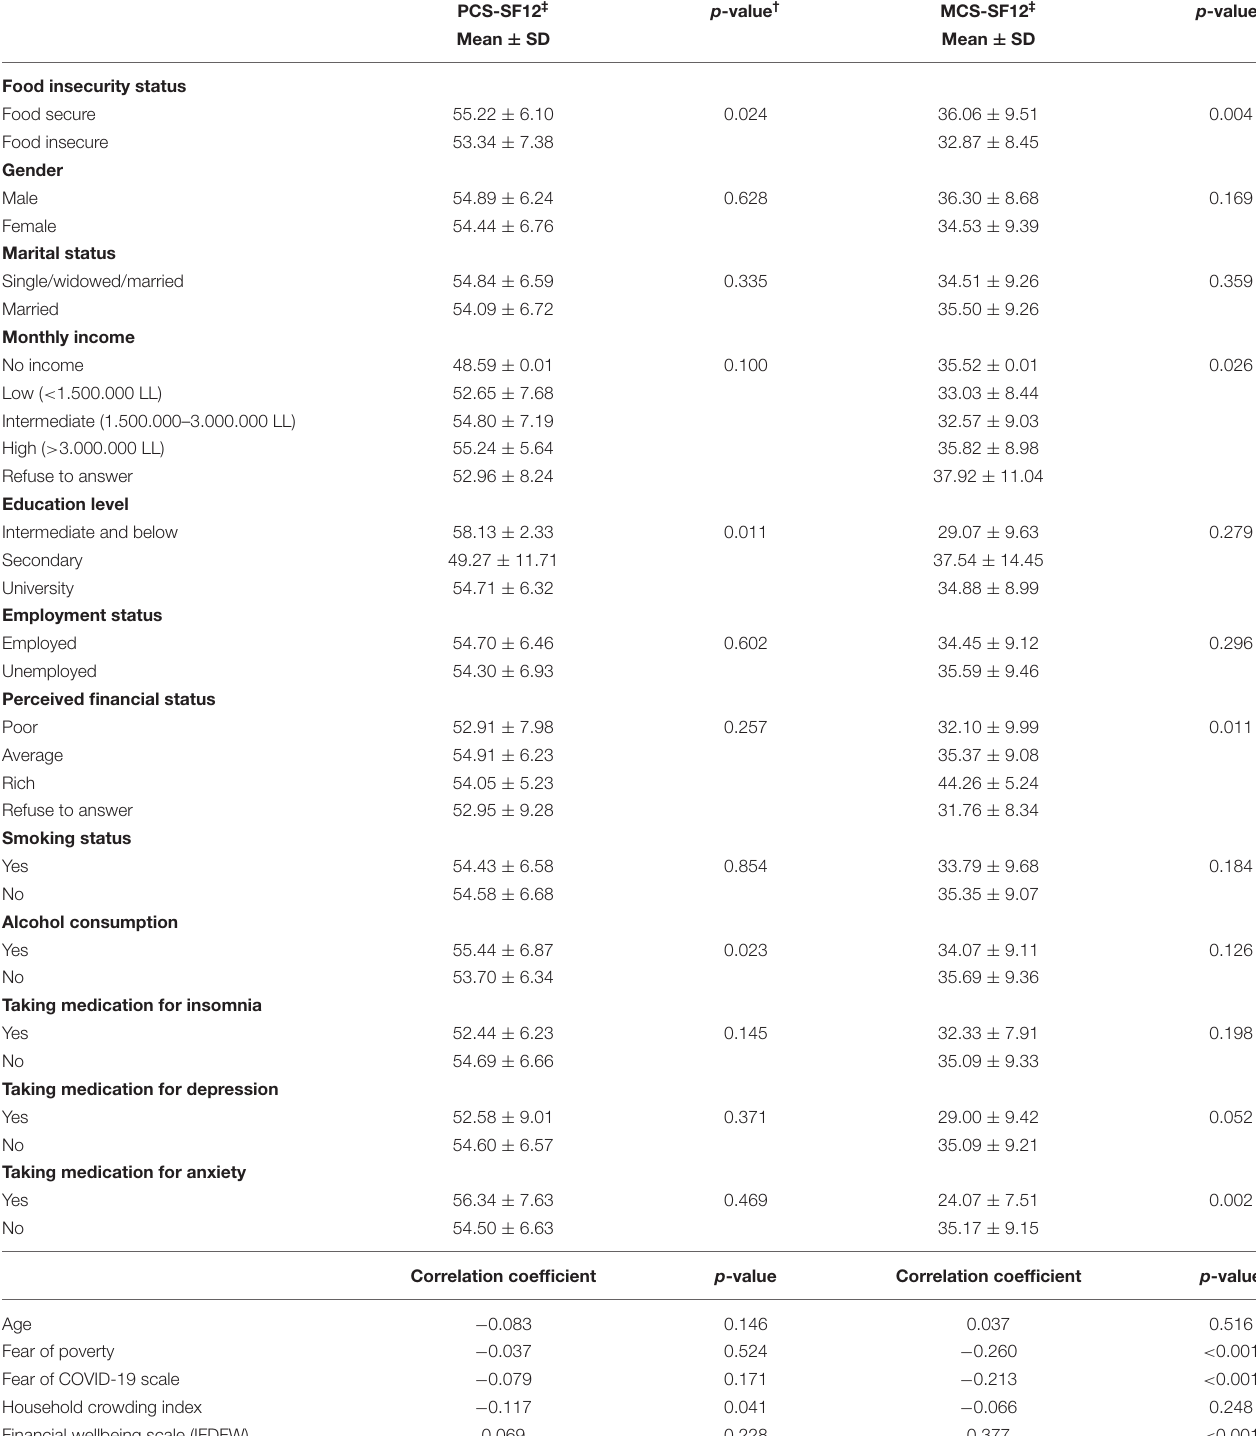
TABLE 2 | Bivariate associations between food insecurity, sociodemographic and economic characteristics of study participants with their quality of life parameters SF-12 components (PCS-SF12 and